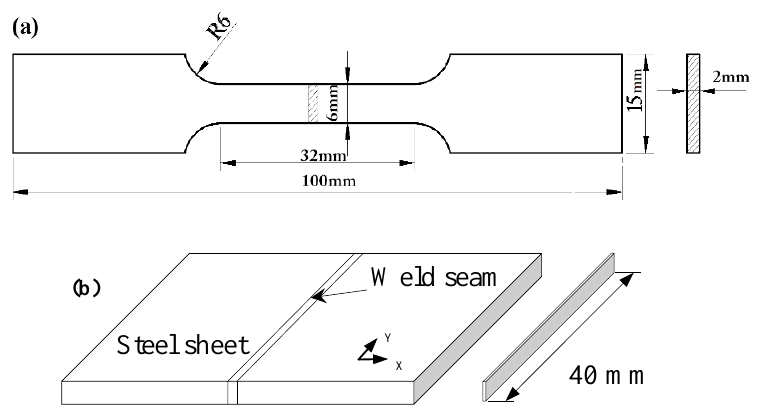
Figure 2. Schematic of the uniaxial tensile test sample of ( a ) welded joints and ( b ) hardening zone (HZ).